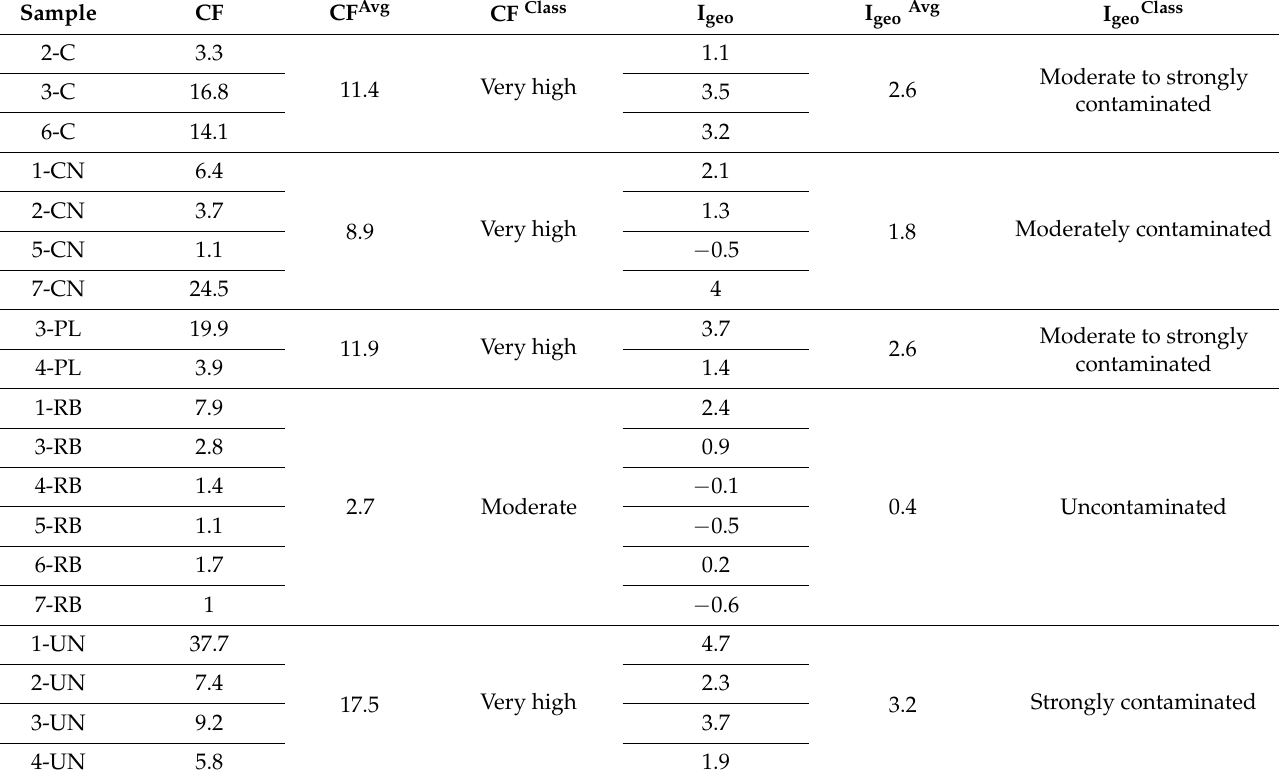
Table 3. Contamination factor (CF) and geoaccumulation index ( I geo ) of